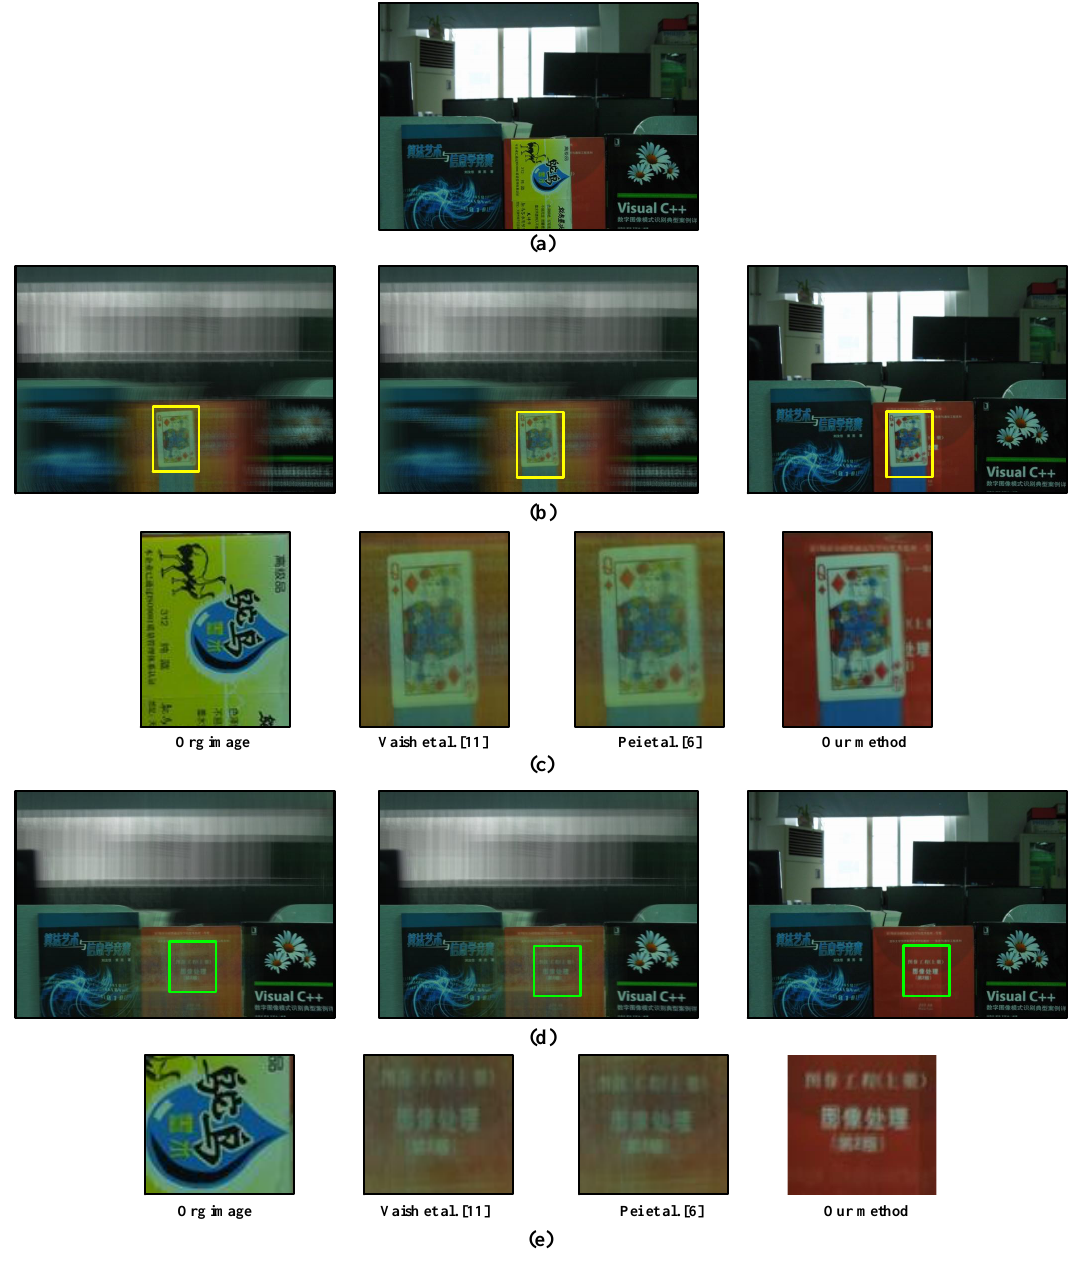
Figure 9. Comparison results of synthetic aperture imaging through multiple objects. ( a ) Original reference image; ( b ) Imaging result through the front object by Vaish, Pei and our method; ( c ) Comparison results through the first occluder; ( d ) Imaging result through the second object by Vaish, Pei and our method; ( e ) Comparison results through the second